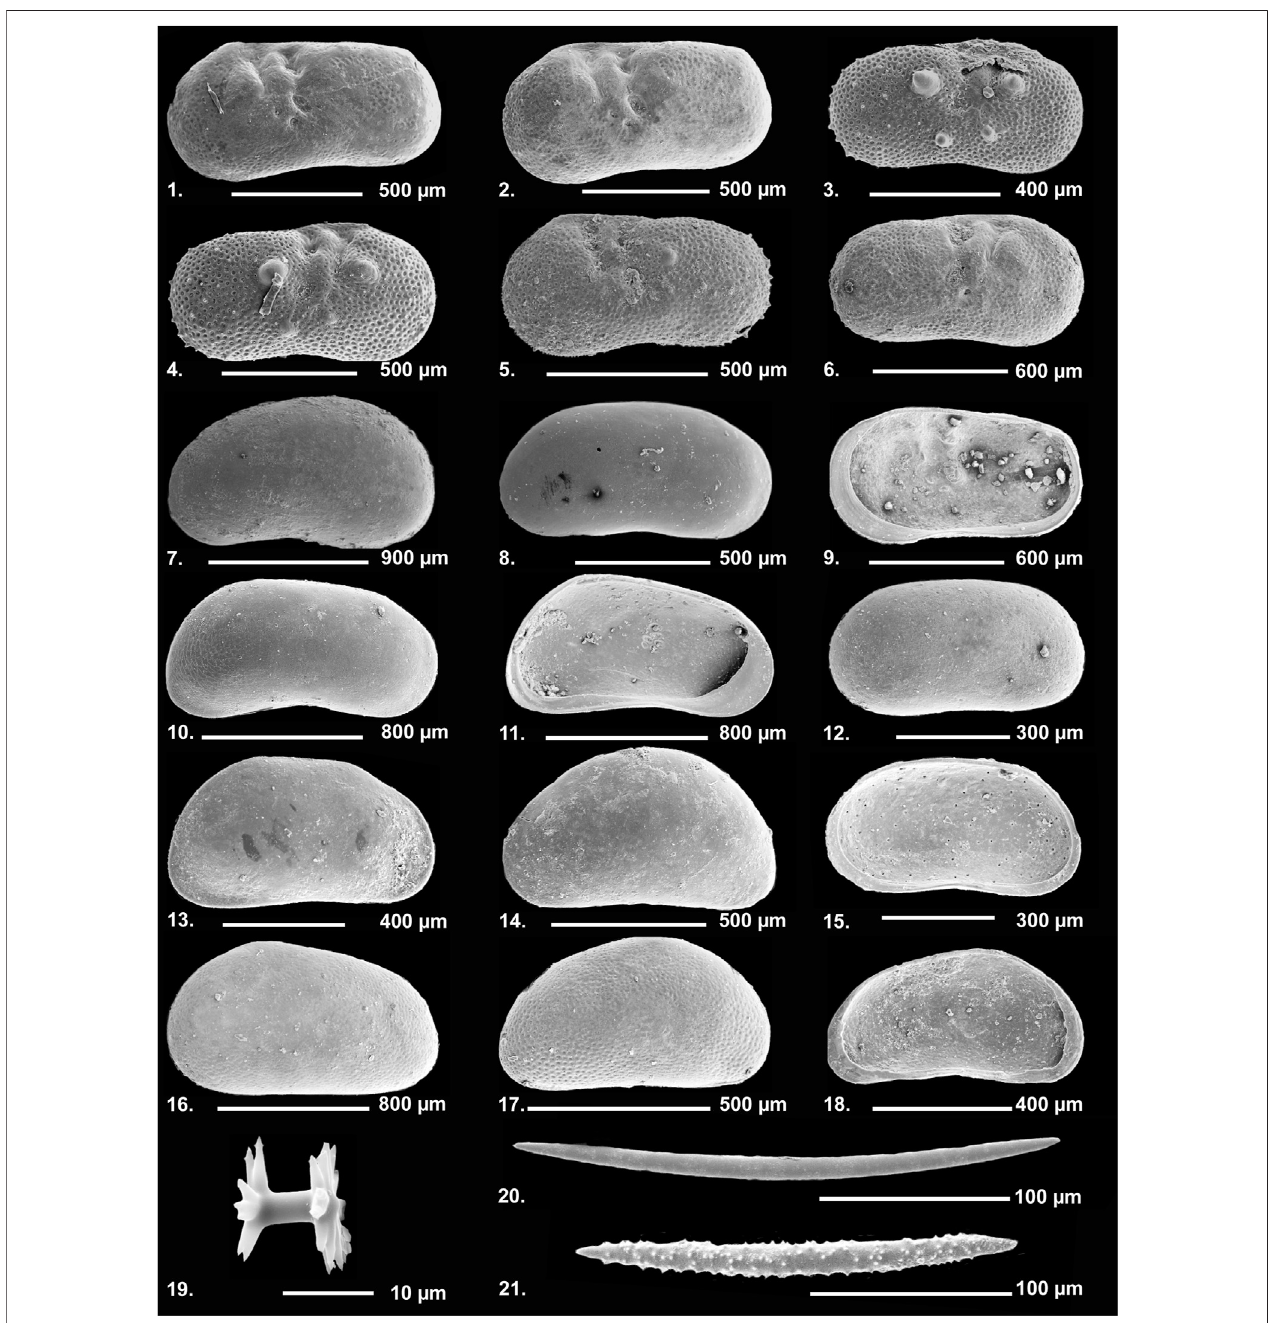
FIGURE 4 | SEM images of ostracods (1 – 18) and sponge spicules (19 – 21) from Marathousa-1 Area A and Area B. RV (cid:1) right valve, LV (cid:1) left valve, A (cid:1) adult, im (cid:1) immature, fem (cid:1) female, m (cid:1) male, ext (cid:1) external view, int (cid:1) internal view. 1) Ilyocypris getica , LV, a, fem, ext. 2) I. gibba , LV, a, fem, ext. 3) I. gibba , RV, im, ext. 4) I. decipiens ,RV,im,ext;5) I.decipiens ,LV,im,ext;6) I.bradyi ,RV,a,fem,ext.7) Candonaneglecta ,LV,a,m,ext.8) C.neglecta ,RV,im,ext;9) I.bradyi ,RV,a,fem,int.10) Neglecandona altoides , RV, a, fem, ext. 11) N. altoides , RV, a, fem, int. 12) Candona sp., LV, im, ext. 13) Pseudocandona marchica , RV, a, m, ext. 14) Psychrodromus sp.,LV,im,ext.15) Candona sp.,RV,im,int.16) Prionocypriszenkeri ,LV,a,fem,ext.17) Potamocypriszschokkei ,RV,a,ext.18) P.zschokkei ,LV,a,int. Sponge spicules: 19) Gemmoscleres. 20) Megascleres. 21)